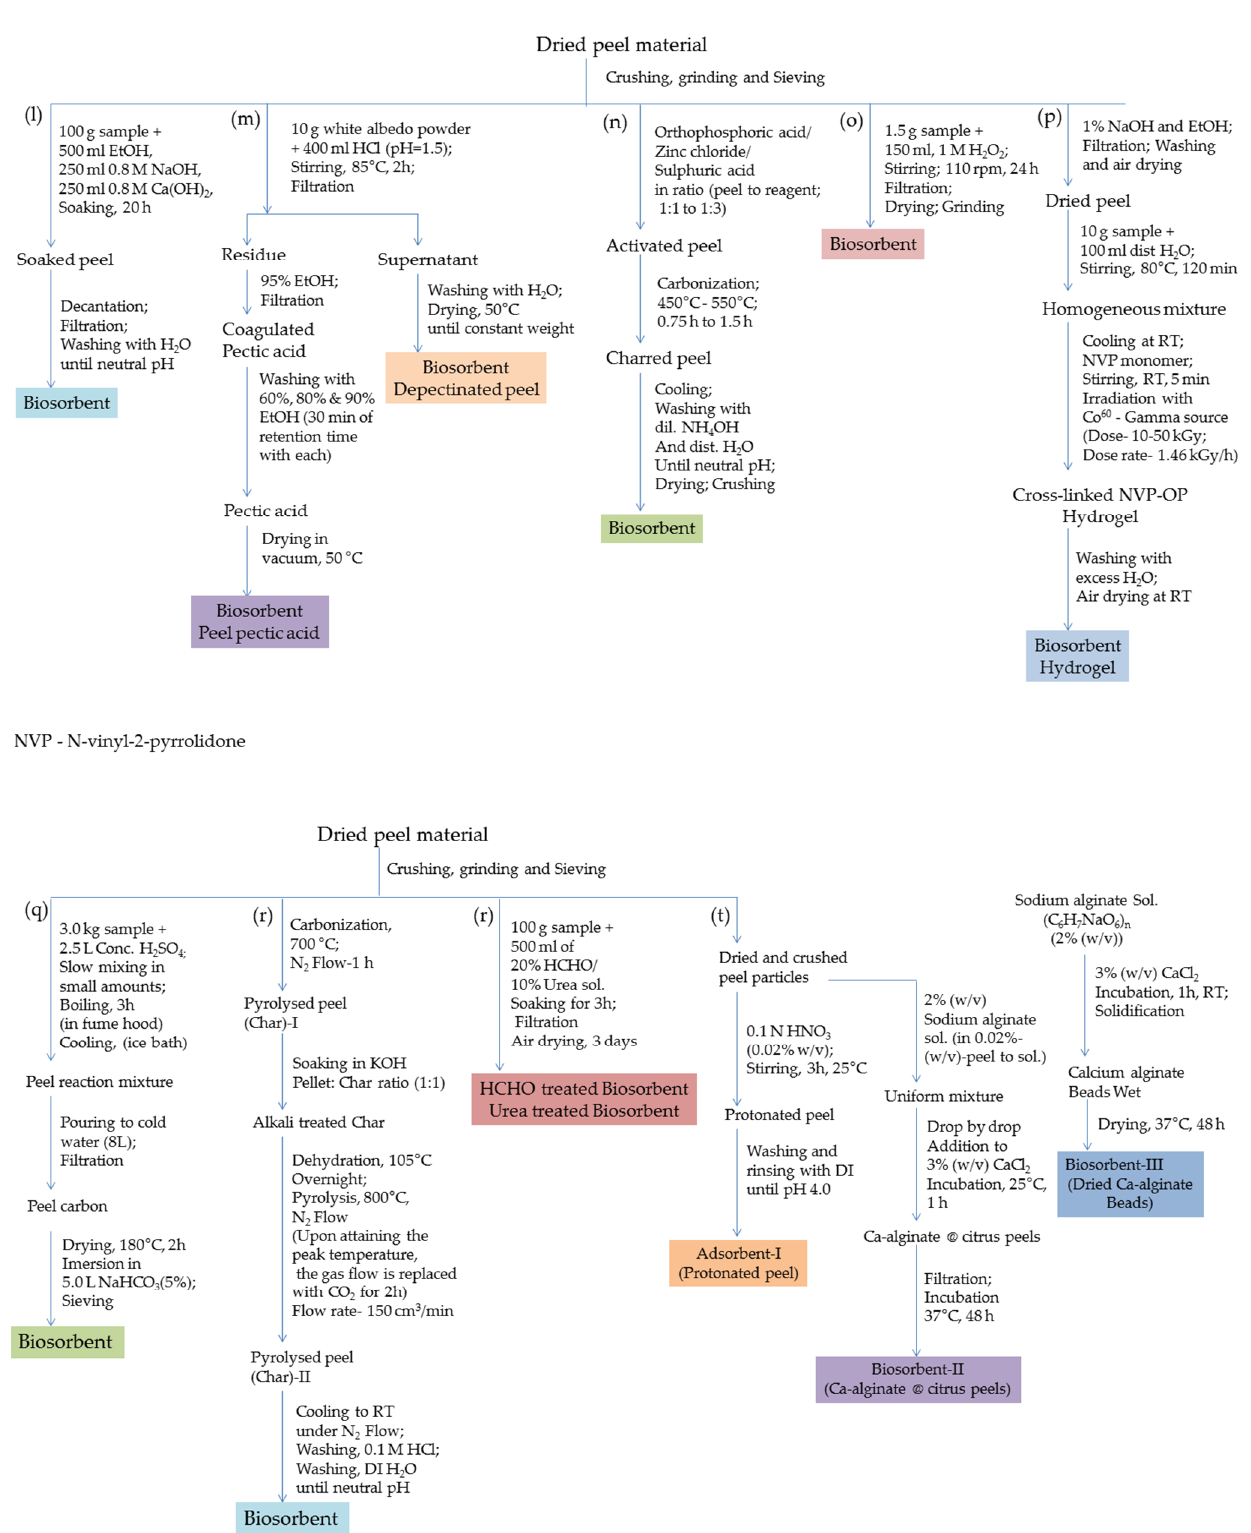
Figure 6. ( a ‒ t ) Different methods of pre-treatment of the precursor material for the preparation of bio-sorbents from citrus wastes [69–76,84–88] .